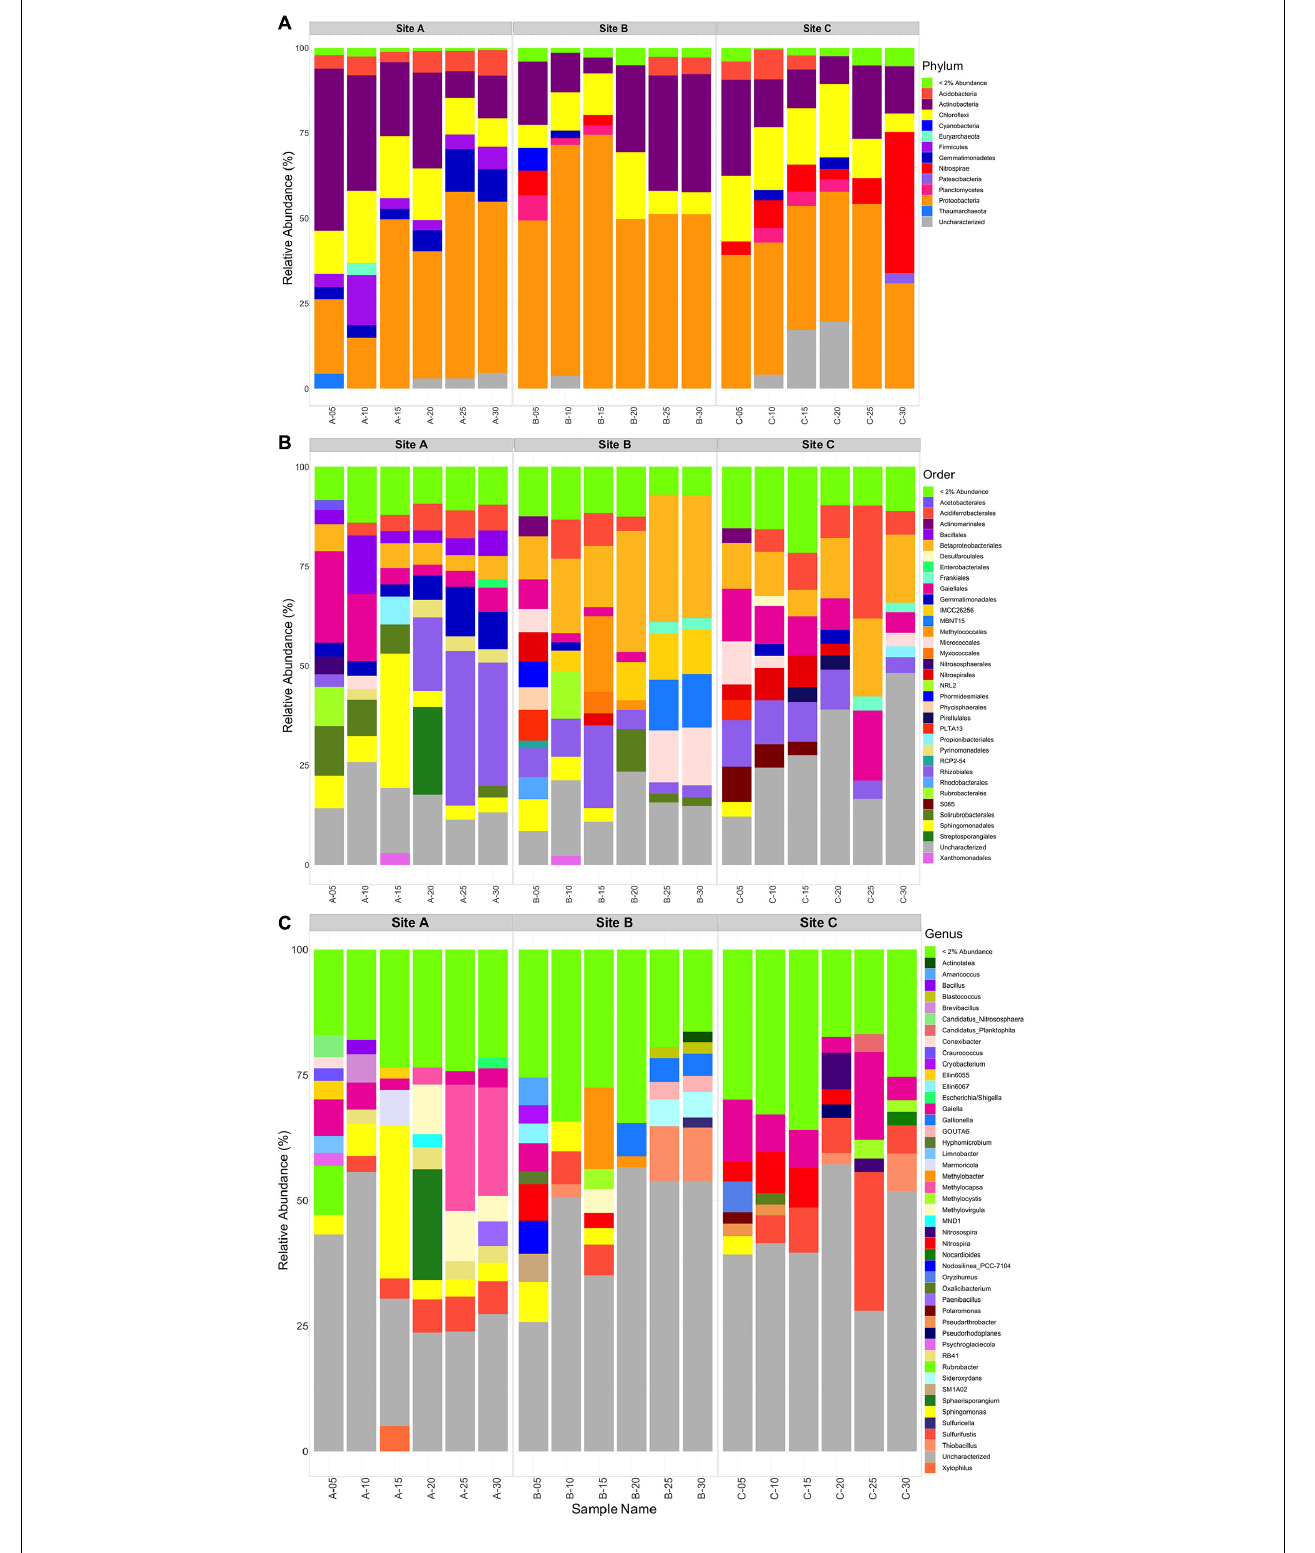
FIGURE 7 | Taxonomic bar plot of the sites A, B, and C tailings microbial communities at the Phylum level (A) , Order level (B) , and the Genus level (C) .